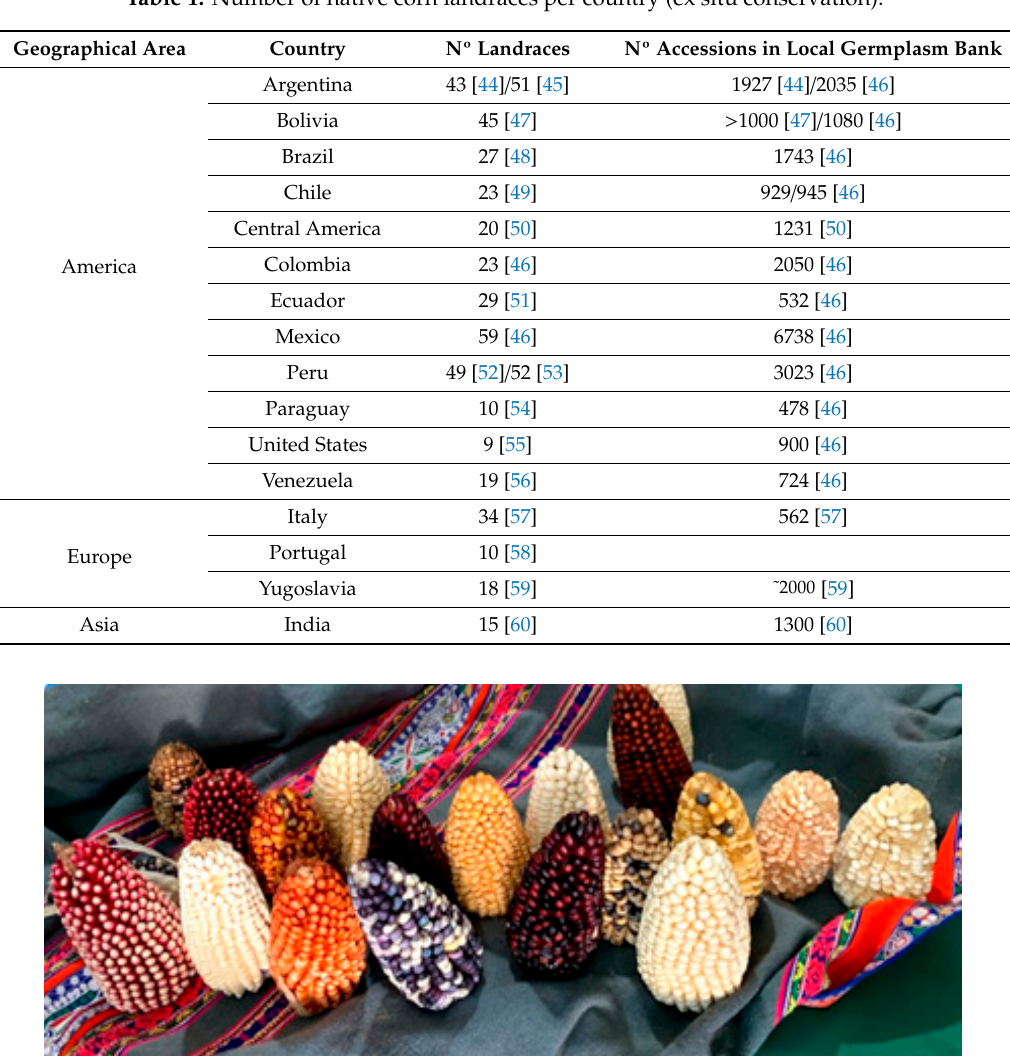
Table 1. Number of native corn landraces per country (ex situ conservation).